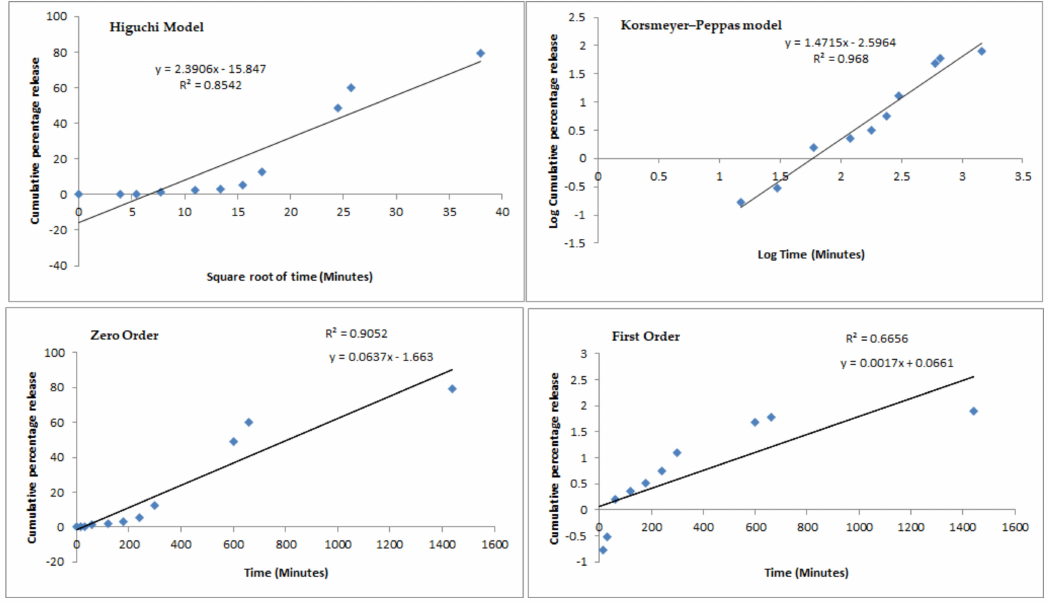
Figure 3. Mathematical fitting models (Higuchi model, Korsmeyer–Peppas model, zero order, and first order) of the cumulative percentage of EGCG release from Eudragit S-100 coated microspheres (S100Ch-PP60) in simulated gastrointestinal conditions.